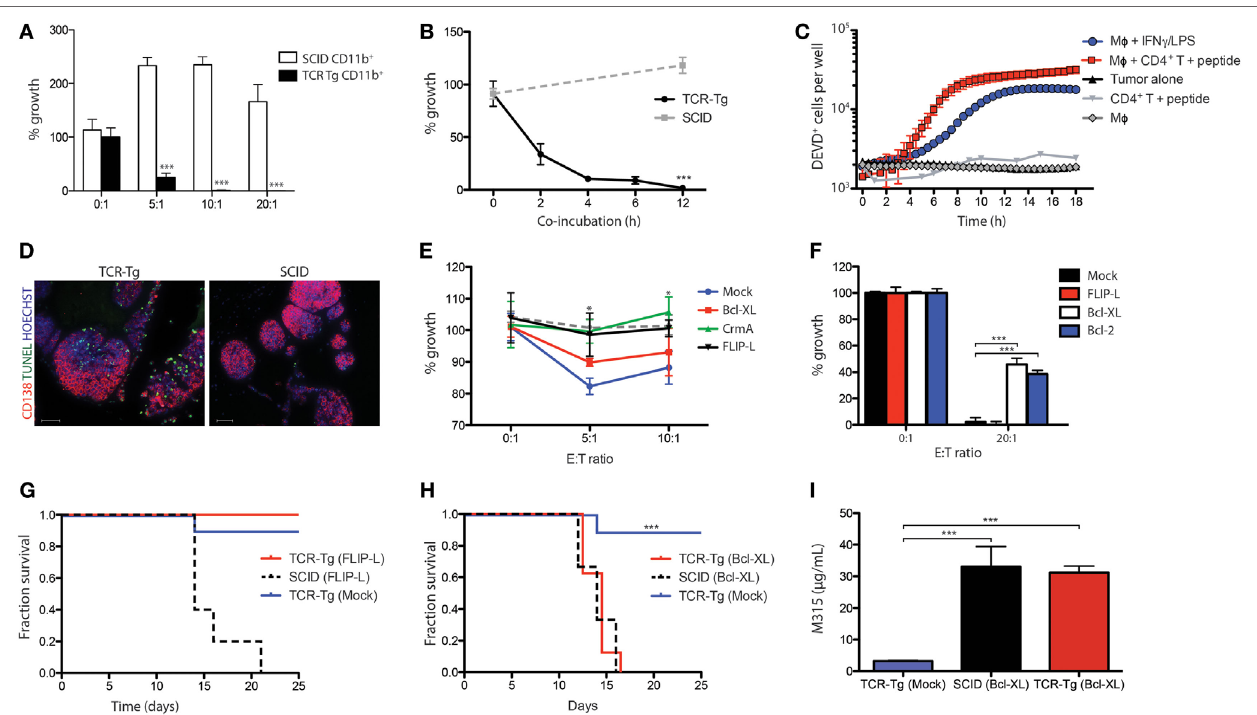
FigUre 1 | Th1/M1 macrophage-mediated killing of myeloma involves the intrinsic apoptotic pathway. (a) Tumor cell growth inhibition assay showing the growth of tumor cells co-incubated for 24 h with Matrigel-derived CD11b + cells isolated from T cell receptor-transgenic (TCR-Tg) (black bars) or SCID (white bars) mice at day + 12 following tumor challenge at the indicated ratios. Cells were cultured for 48 h ( n = 4 per treatment condition), with the addition of 3 H-thymidine for the last 18 h of culture. Growth was expressed as percentage counts per minute (cpm) of tumor cells cultured alone. *** signifies p < 0.001. (B) Time-dependence of macrophage-mediated cytotoxicity assayed in a tumor cell growth inhibition assay. CD11b + cells were isolated from the Matrigel tumor bed at day + 12 following tumor challenge in either TCR-Tg SCID or SCID mice, and co-incubated in vitro with tumor cells at a 20:1 ratio for the indicated time periods. The non-adherent tumor cells were then isolated, washed, and cultured for 48 h, with addition of 3 H-thymidine for the last 18 h of culture. Growth was expressed as percentage of tumor cells cultured alone (mean ± SD). (c) Co-incubation assays showing accumulation of the cleaved form of the caspase 3/7 substrate DEVD within tumor cells incubated in the presence of macrophages (M ϕ ), Id-specific CD4 + T cells, and synthetic Id peptide, as indicated. (D) TUNEL staining (green) of cryosections from Matrigel isolated from TCR-Tg and SCID mice at day + 10 following subcutaneous challenge with 1.6 × 10 5 MOPC315. Sections were counterstained with anti-CD138 (red) and Hoechst (blue). Images were taken using identical exposure settings. Images are representative of three independent assays with six replicates per group. (e) Cytotoxicity assay showing the effect of the presence of irradiated (30 Gy) FasL-expressing T-lymphoma cell line FasL/L5178Y on the growth of MOPC315 cells transduced with pMSCV-IRES-EGFP (Mock) and MOPC315 variants overexpressing Bcl-XL, cytokine response modifier A (CrmA) or FLIP-L. Mock-transfected cells co-incubated with the wild-type L5178Y variant are represented by the dotted line. Cells were co-incubated for 48 h at the indicated ratios ( n = 8 per treatment condition), with addition of 3 H-thymidine for the last 18 h of culture. Growth was expressed as percentage cpm of tumor cells cultured alone for the statistical difference of CrmA- and FLIP-L-overexpressing cells relative to control (Mock). (F) Impact of overexpression of FLIP-L, Bcl-XL, or Bcl-2 in tumor cells on macrophage cytotoxicity. Controls were transduced with the pMSCV-IRES-EGFP vector alone (Mock). Tumor cells were cultured alone or co-incubated with interferon gamma (IFN- γ )/LPS-activated macrophages at a 20:1 for 6 h, washed and cultured for 24 h, with addition of 3 H-thymidine for the last 18 h of culture. (g,h) Survival curves for either Id-specific TCR-Tg or SCID mice challenge with 1.6 × 10 5 tumor cells ( n = 6 per group) overexpressing FLIP-L (g) or Bcl-XL (h) . (i) Average serum M315 levels in mice from the experiment shown in (h) at the time of tumor detection (day 12–16; n = 6 per